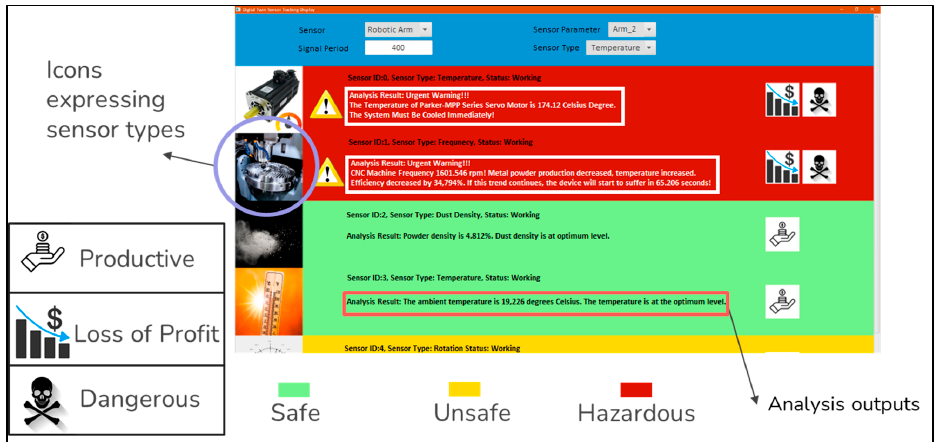
Figure 8. An example of the sensor data and analysis tracking screen.